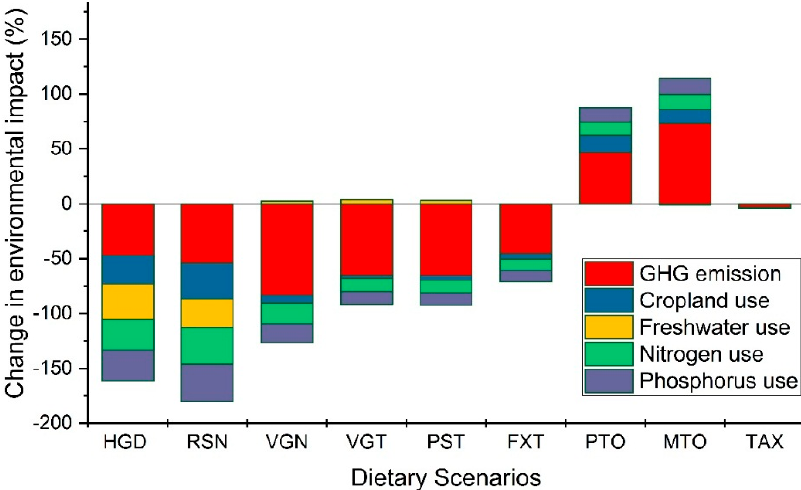
Figure 3. The environmental footprint of the nine alternative diets relative to the current diet. It can be seen that shifting from current to the meat oriented (MTO) and protein oriented (PTO) diets will increase the environmental footprint across all five domains (GHG, water, land, nitrogen and phosphorus) while a shift to the RSN diet (recommended by Swiss society of nutrition) will lead to maximum reduction in footprints. See Supplementary Table S5 for contribution of different food groups to the total environmental footprint.